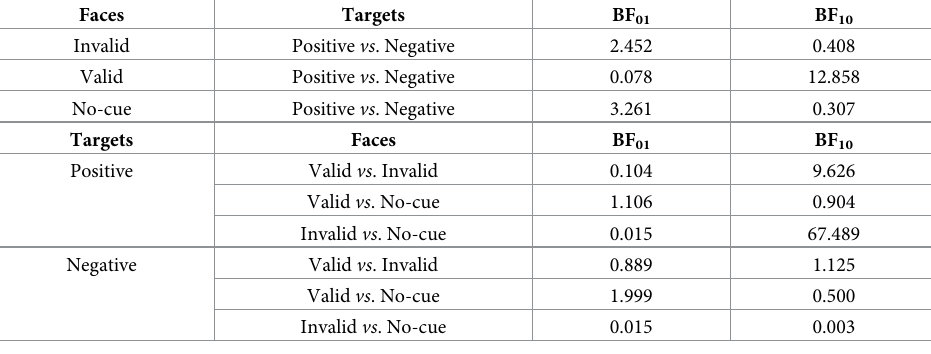
Table 1. Results of Bayesian paired samples t-tests in Experiment 1.